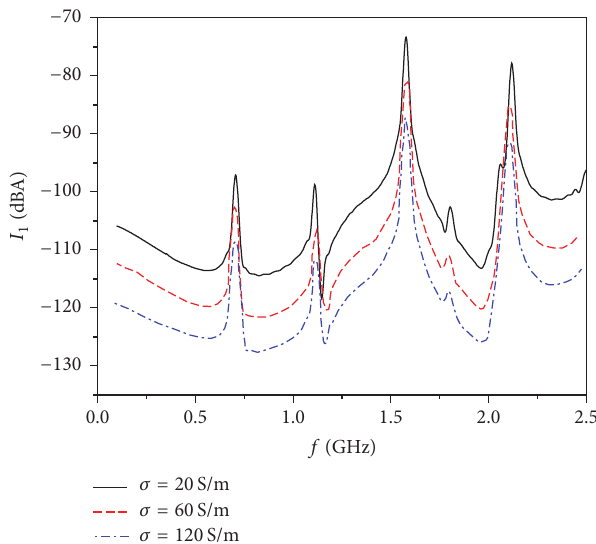
Figure 8: Electric current induced at the termination load 𝑍 1 for different sheet